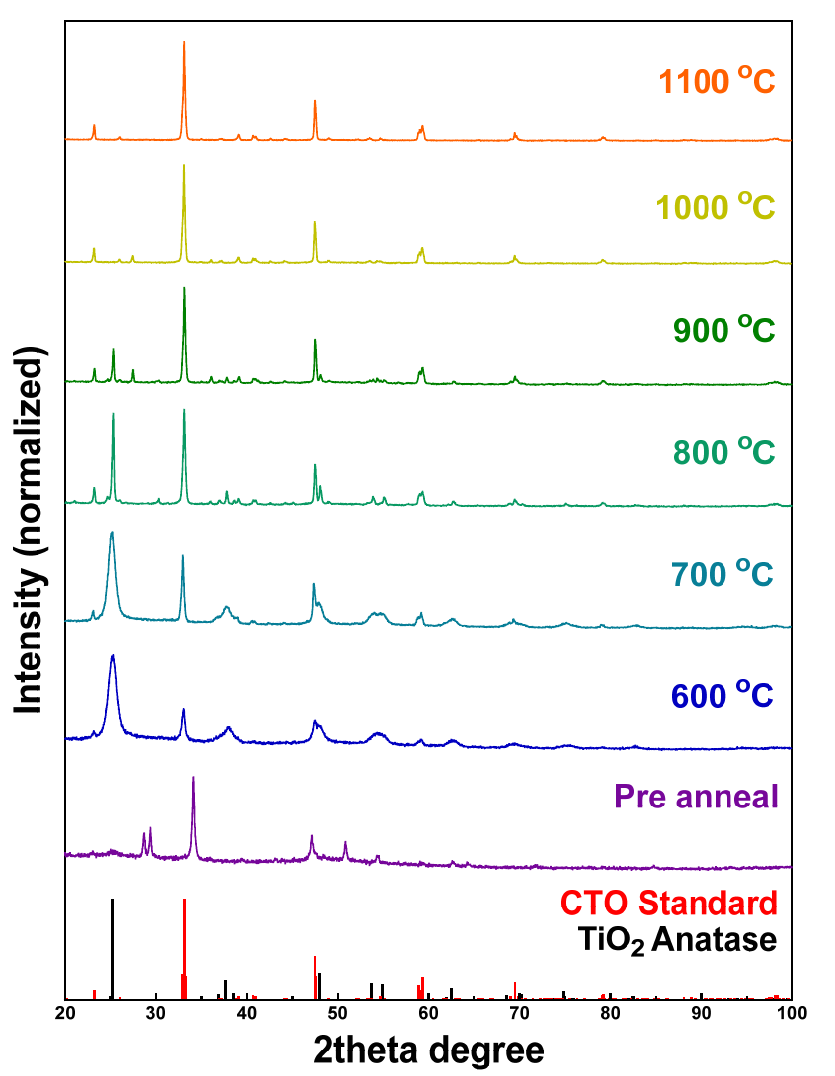
Figure 3. XRD patterns of a CTO powder sample calcined from 600 ◦ C to 1100 ◦ C, in increments of 100 ◦ C. The data on all samples were acquired after the acid wash, except for the pre-annealed sample. Samples are compared with standard anatase TiO 2 and CTO patterns.